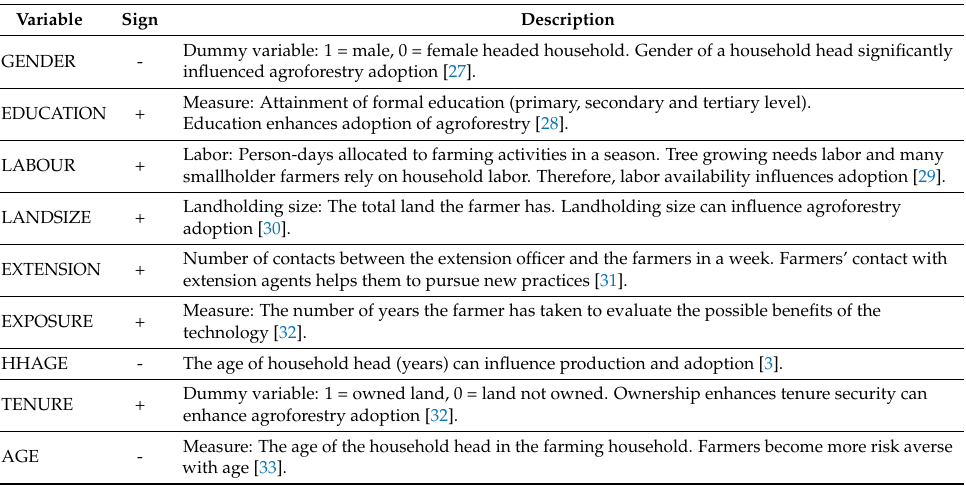
Table 1. Variables expected signs and their